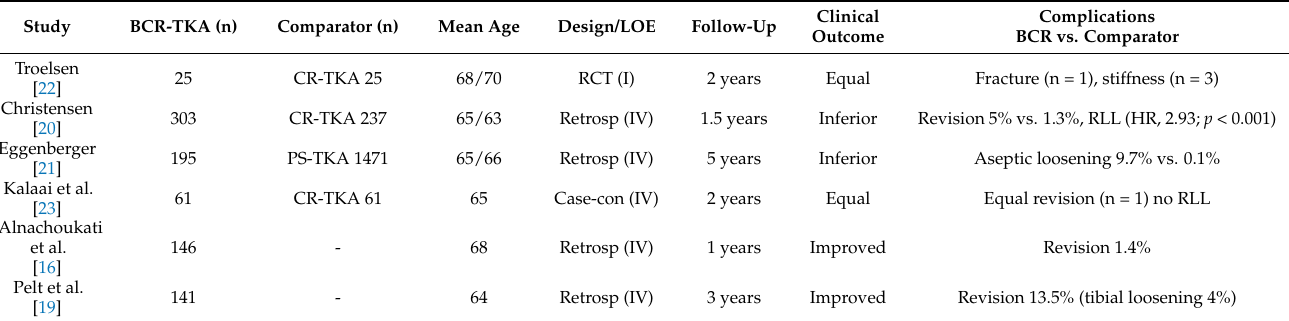
Table 2. Clinical outcome studies for Vanguard XP